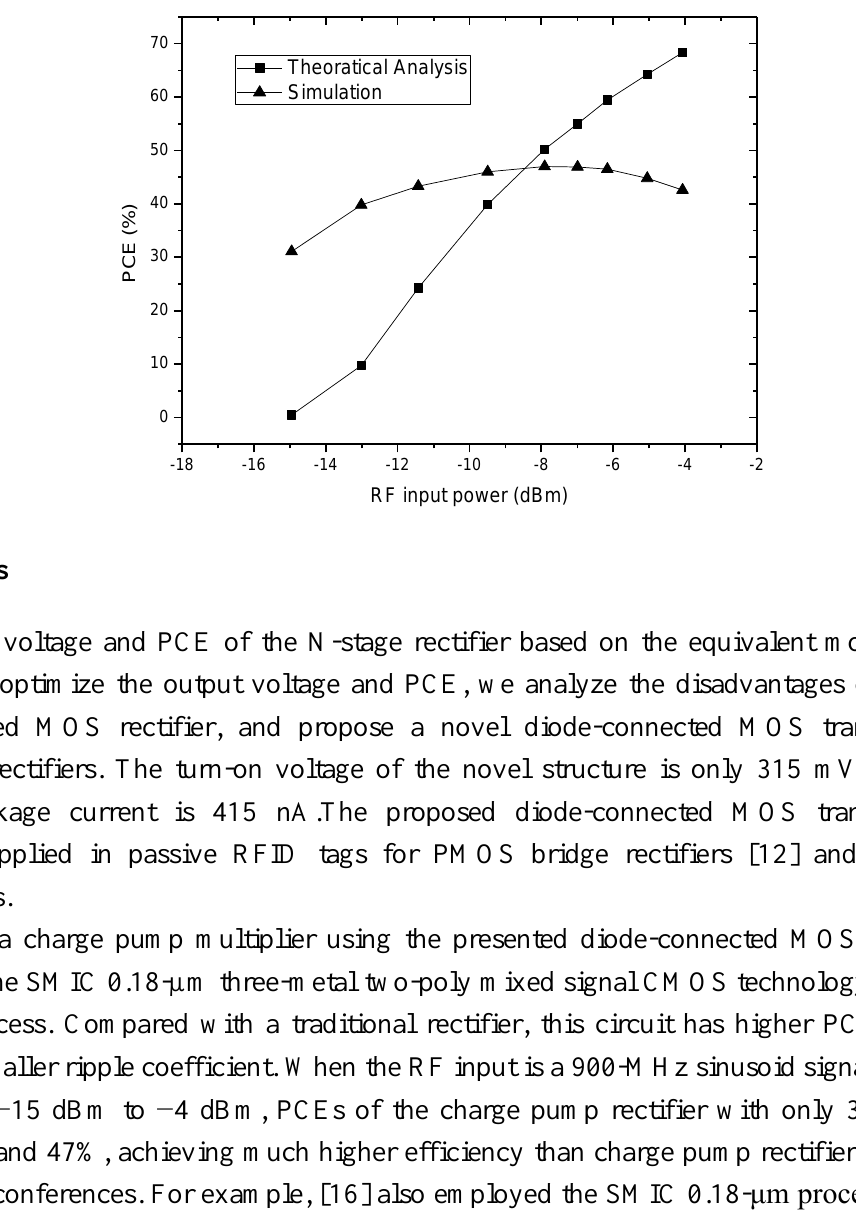
Figure 15. Comparison of the PCE of the theoretical analysis and simulation